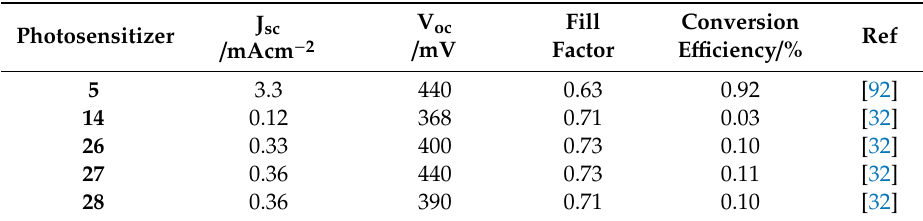
Table 2. Best current solar cell characteristics for iron-carbenes reported as photosensitizers in DSSCs. Note that only DSSCs with complex 5 as photosensitizer have been subjected to significant optimization e ff orts beyond an initial DSSC performance